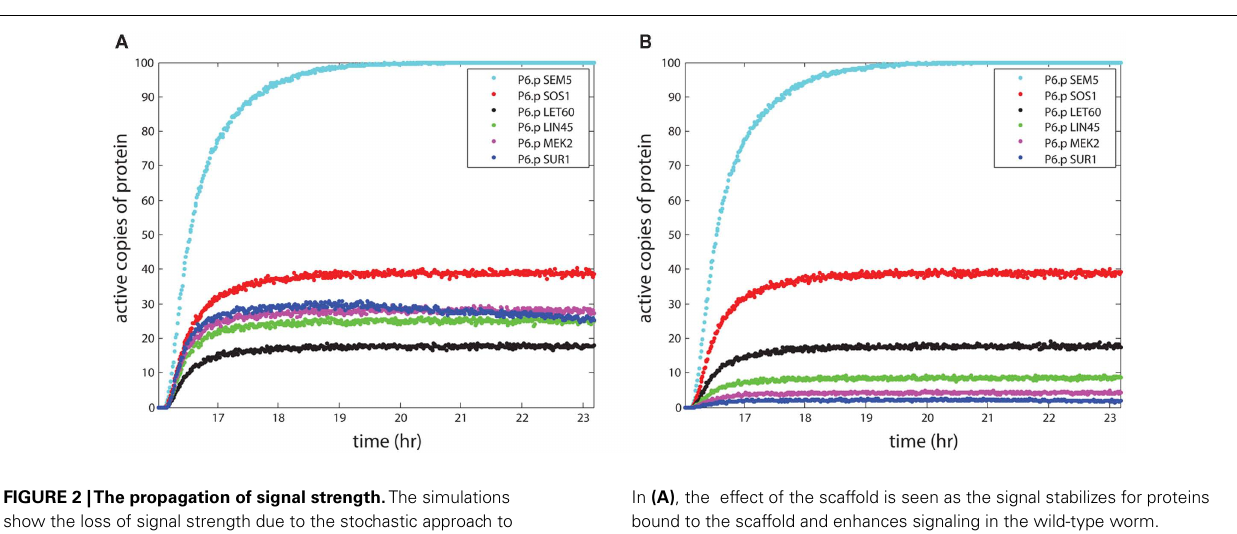
FIGURE 2 |The propagation of signal strength. The simulations show the loss of signal strength due to the stochastic approach to modeling signaling.The y -axis shows the mean number of active proteins averaged across 100 organisms in the centralVPC P6.p.